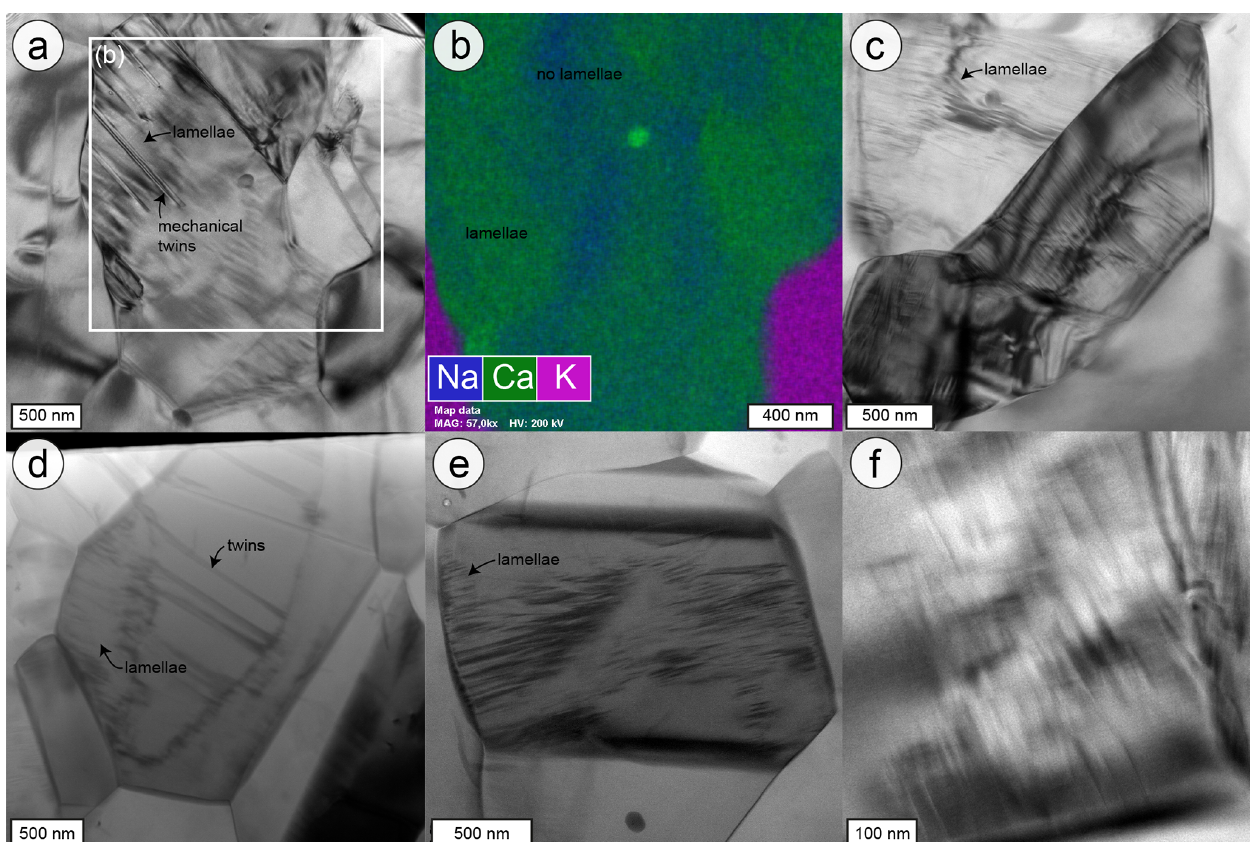
Figure 6. Plagioclase intergrowths in MF1. (a) BF-TEM image of the submicron lamellae in a plagioclase grains that are overlain by mechanical twins. (b) EDX map showing the distribution of Ca and Na in the plagioclase grains associated with the intergrowth in panel (a) . The Ca-rich domains overlay the lamellae. (c) BF-TEM image of lamellae in two separate grains that show slight curvature. (d) BF-STEM image of discontinuous lamellae within a grain that hosts twins in its core. (e) STEM bright-field image of discontinuous lamellae within a plagioclase grain. (f) Bright-field TEM image of lamellae resembling “tweed” exsolution within